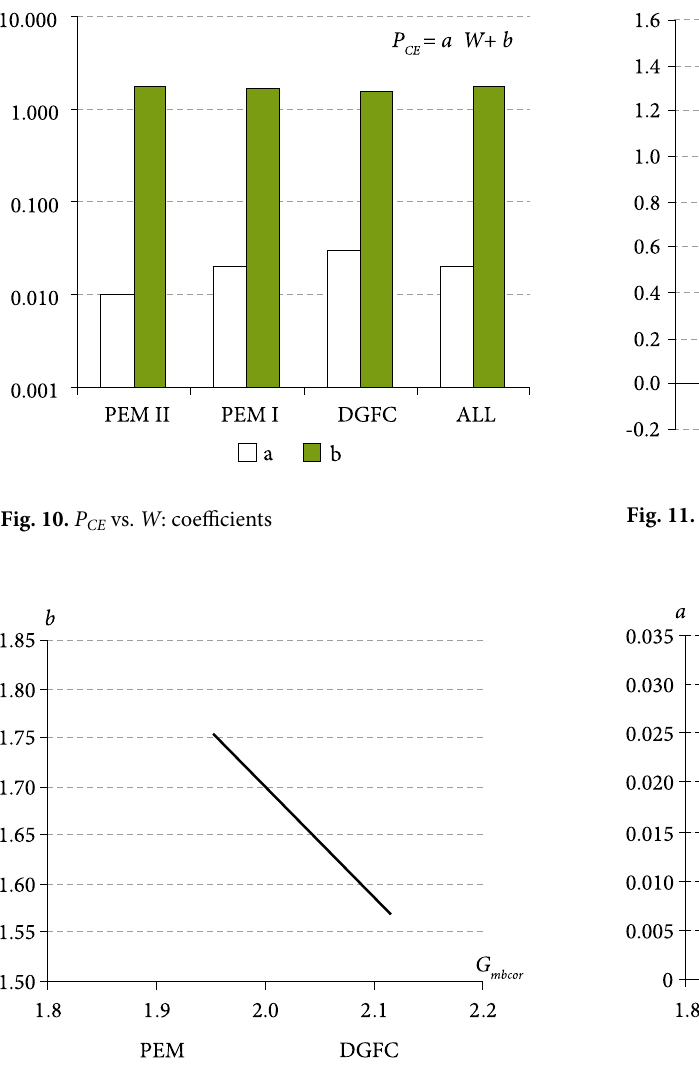
Fig. 13. 1 st derivative a of the correlation P CE = aW + b